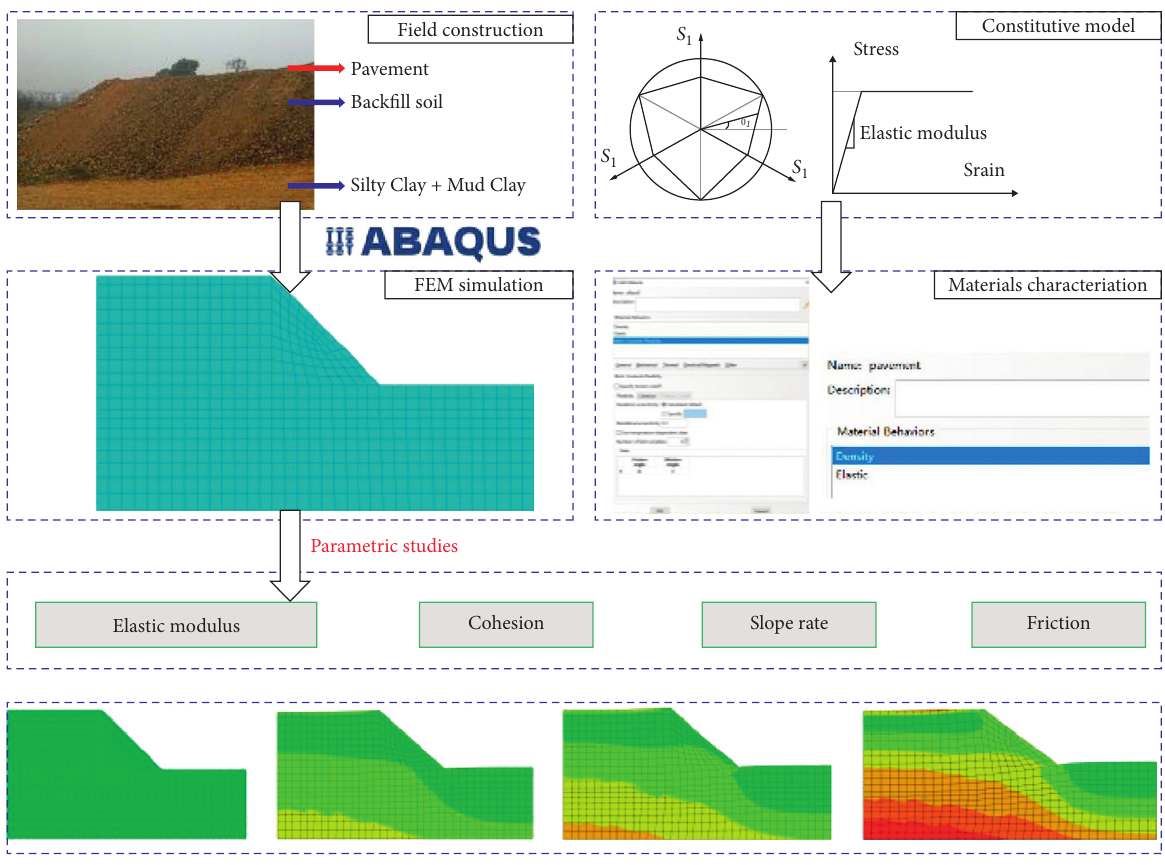
Figure 1: Research objective and